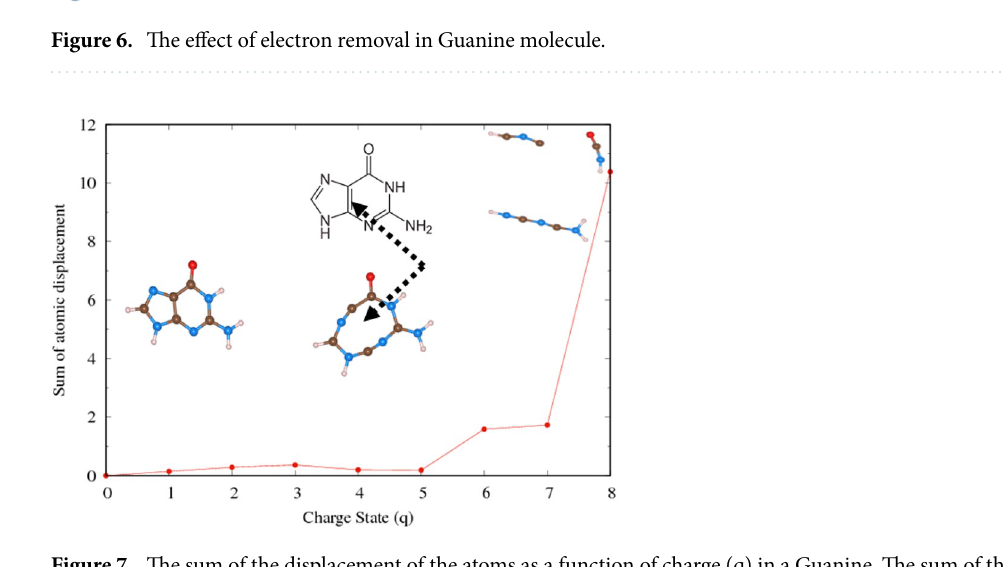
Figure 7. The sum of the displacement of the atoms as a function of charge (q) in a Guanine. The sum of the displacement is in Å and charge is in terms of number of electrons removed.